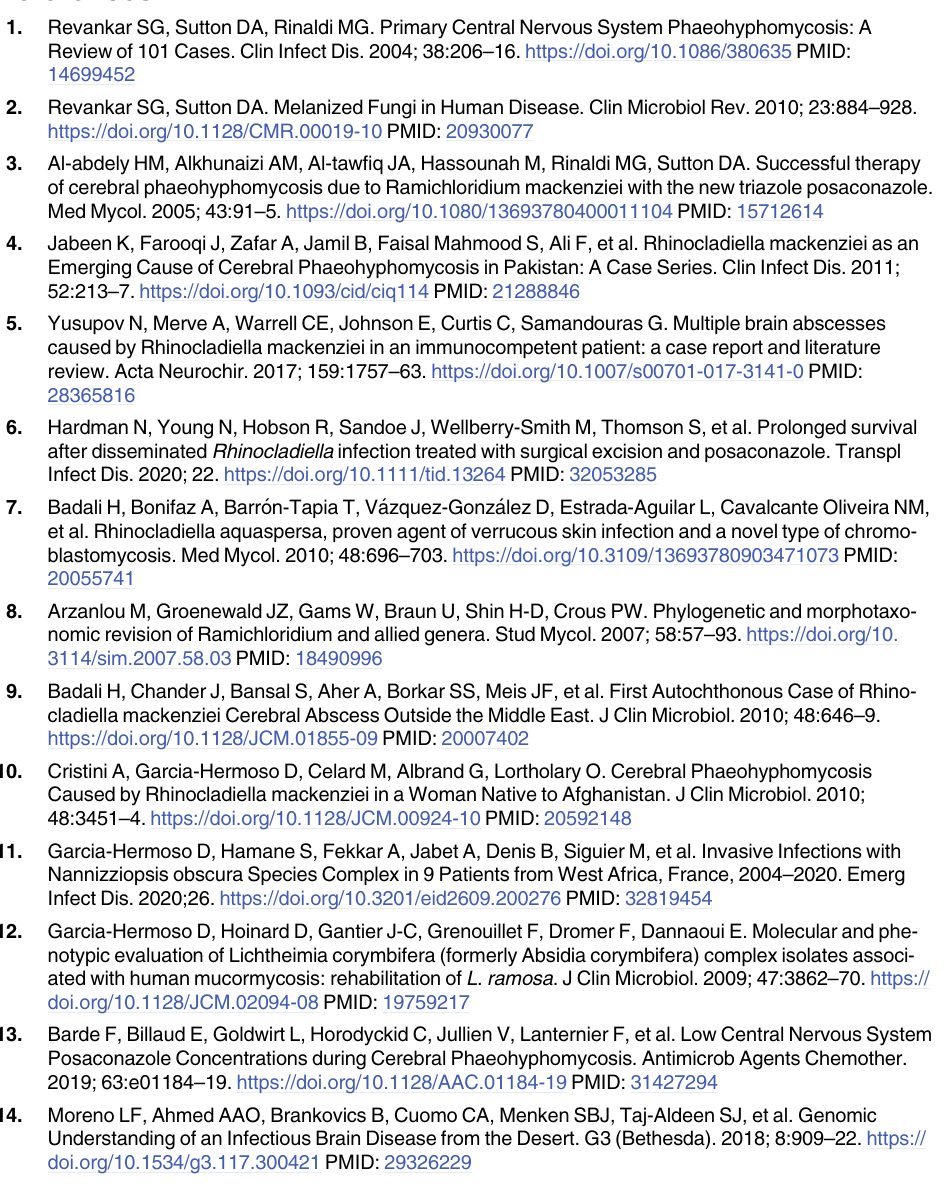
S1 Table. Cases reported in Fig 1. To identify cases, we searched in PubMed using the follow- ing keywords: “ Rhinocladiella mackenzieie ,” “ Ramichloridium obovoideum ,” “ Ramichloridium mackenziei ,” and “ Ramichloridium obovoidea .” We searched from database inception onward without language restrictions. The last search was conducted on May 15,